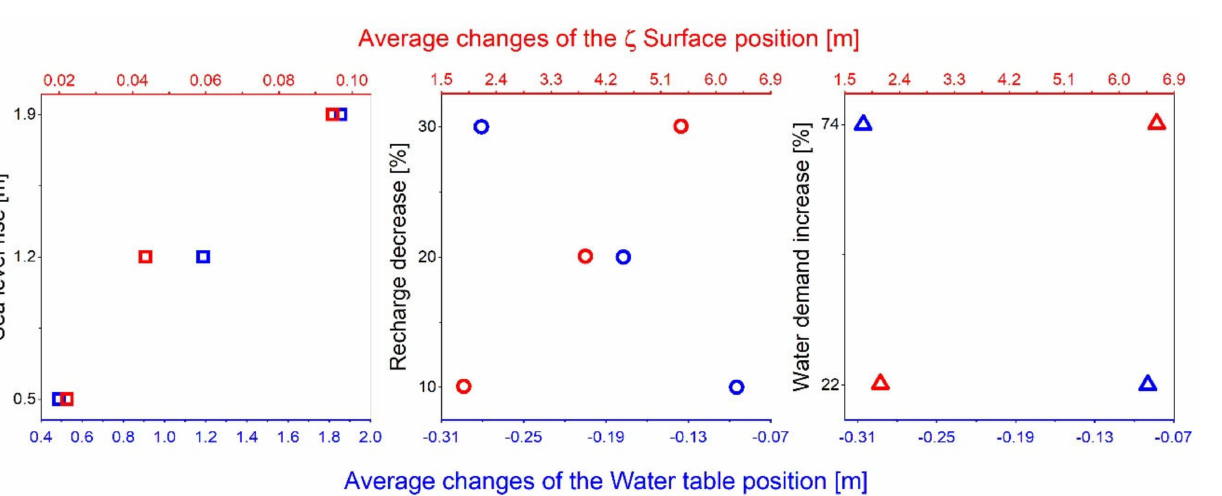
Figure 6. Individual climate change effects evaluated in terms of water table and ζ surface positions calculated for the 2100 scenario with respect to aquifer conditions without any climate change effect (future projection of present day